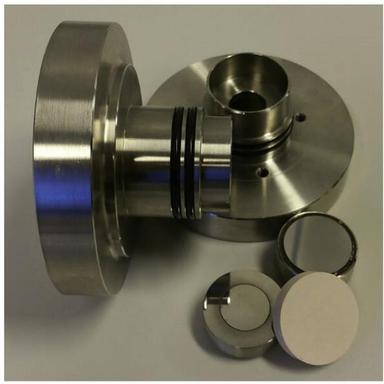
Lumped element instruments include parallel plate capacitors.